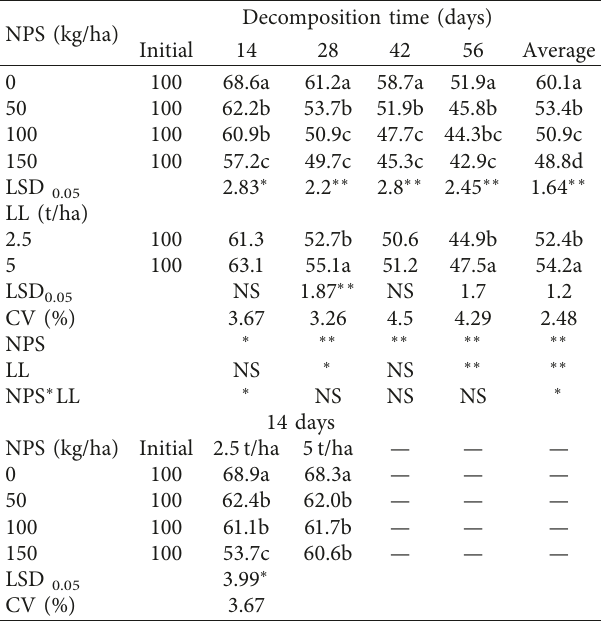
Table 3: Dry mass remaining (% dry weight bases) over 56 days of